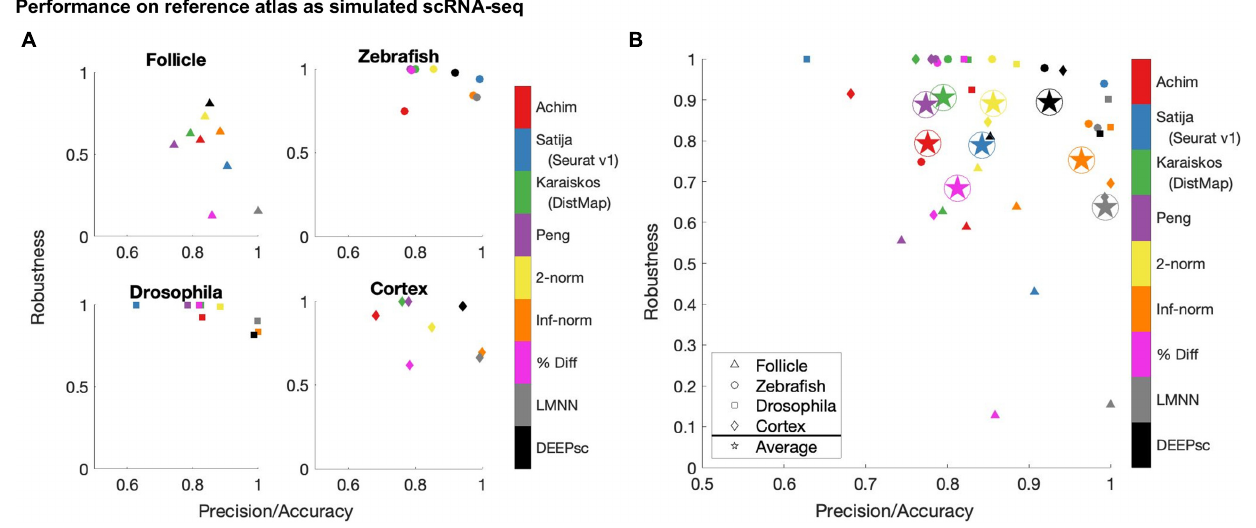
FIGURE 3 | Summary of the robustness, precision, and accuracy scores of the implemented methods on four different biological systems (A) , as well as the simple average across all four (B) . These scores are each defined to be one minus the corresponding penalty term in the performance score, so that a higher score is better. Since most methods have near perfect accuracy scores, the x-axis shows a mean of the precision and accuracy scores. The y-axis shows the robustness scores for each method. Due to memory constraints, we were unable to run Seurat v1 on the cortex